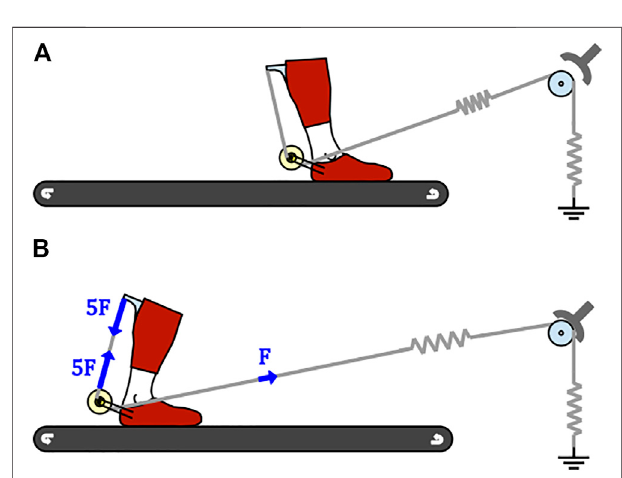
FIGURE 2 | Schematic representation of AN-EXTRA-Push use. (A) AN- EXTRA-Push before the brake is engaged. (B) AN-EXTRA-Push at the moment of peak forces present in the